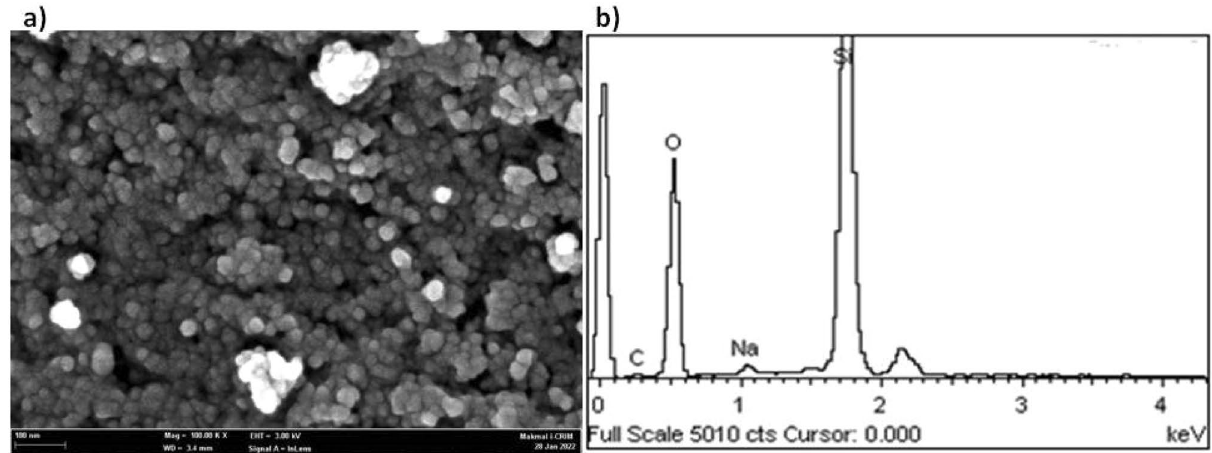
Figure 3. ( a ) FESEM micrograph and ( b ) EDX spectra of silica nanoparticles synthesized from UKMRC-8 rice husk